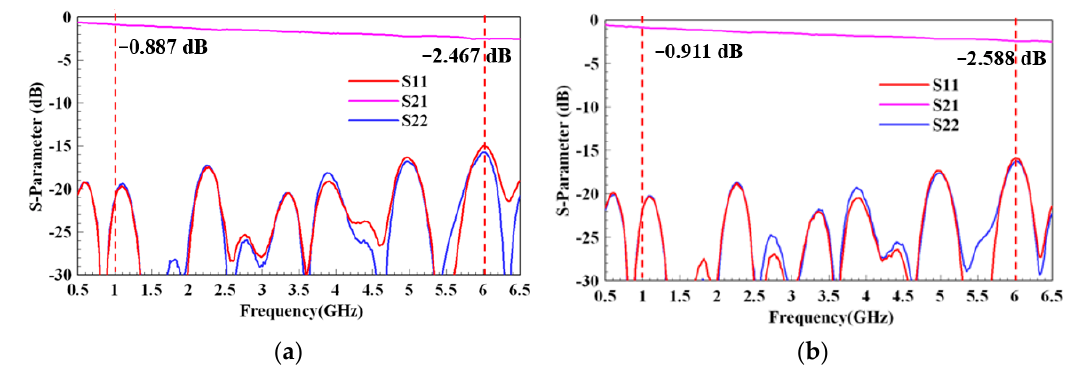
Figure 16. Measurement results of ( a ) Scenario 2 and ( b ) Scenario 4. Table 4. Summary of specification, simulation, and measurement data.